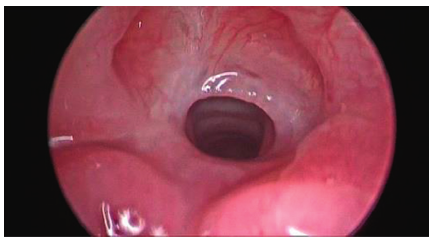
Figure 2: Anterior glottic web.